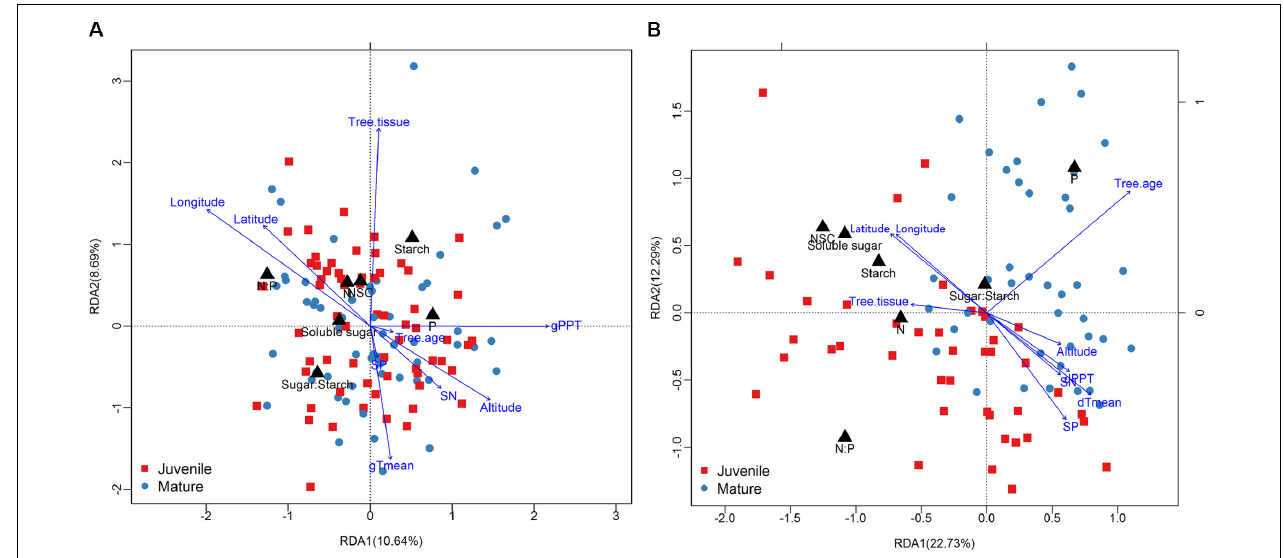
FIGURE 5 | Results of redundancy analysis [ (A) : growing season; (B) : dormant season] showing samples (mature tree: dark blue points; juvenile tree: red square), responsive variables (black triangle), and affecting factors (blue arrow).